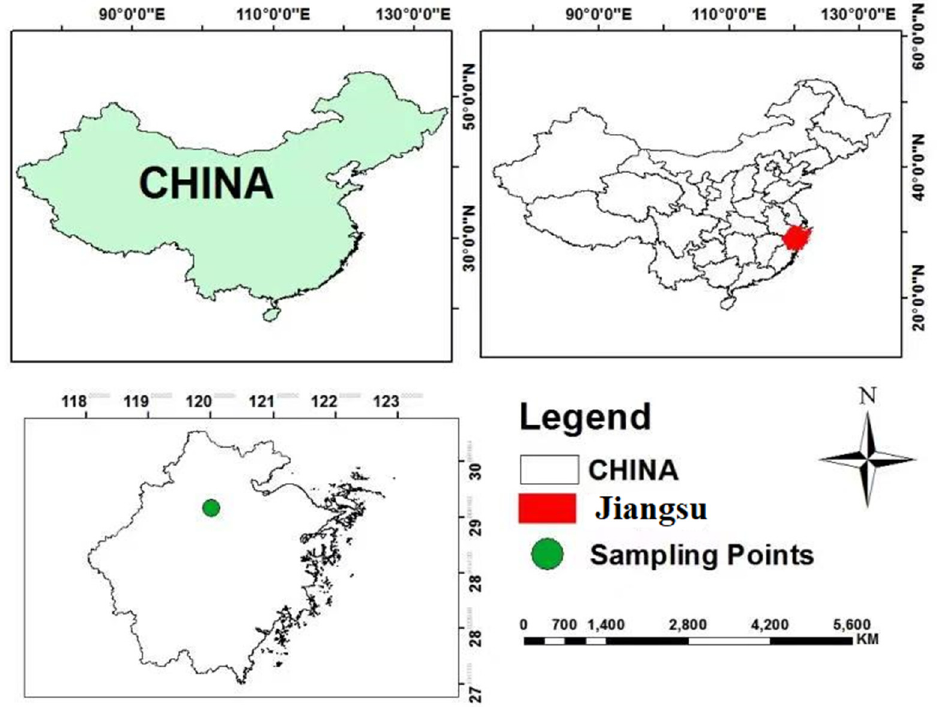
Figure 1. Sample collection point at Jiangsu Province, China.